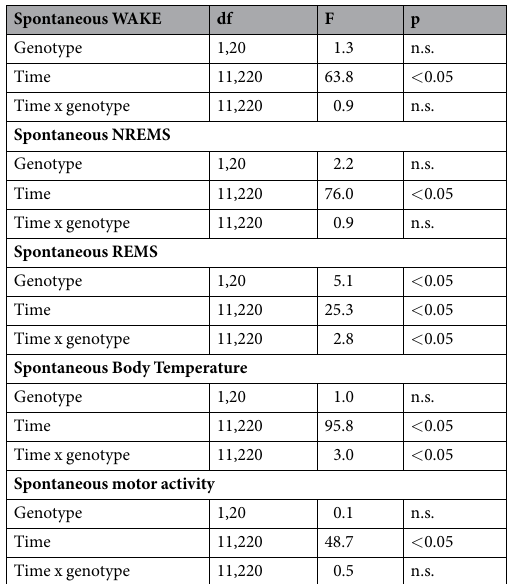
Table 1. Comparisons of spontaneous sleep-wake activity, body temperature and motor activity rhythms between IL-4 R α KO and Balb/c mice – statistical